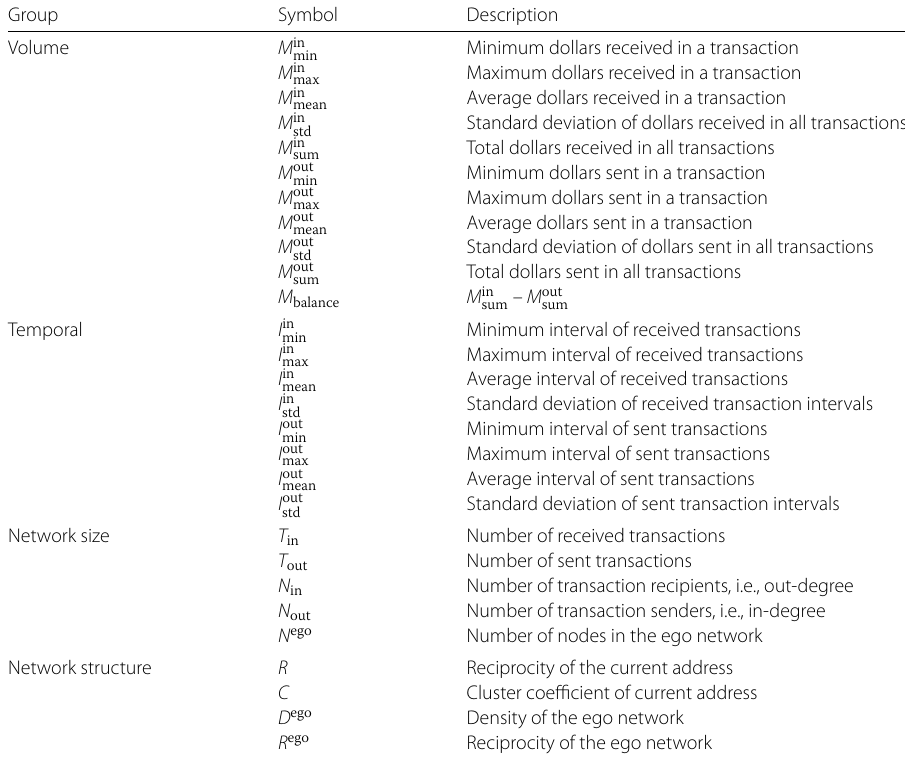
Table 2 Four groups of transaction pattern features for each blockchain address